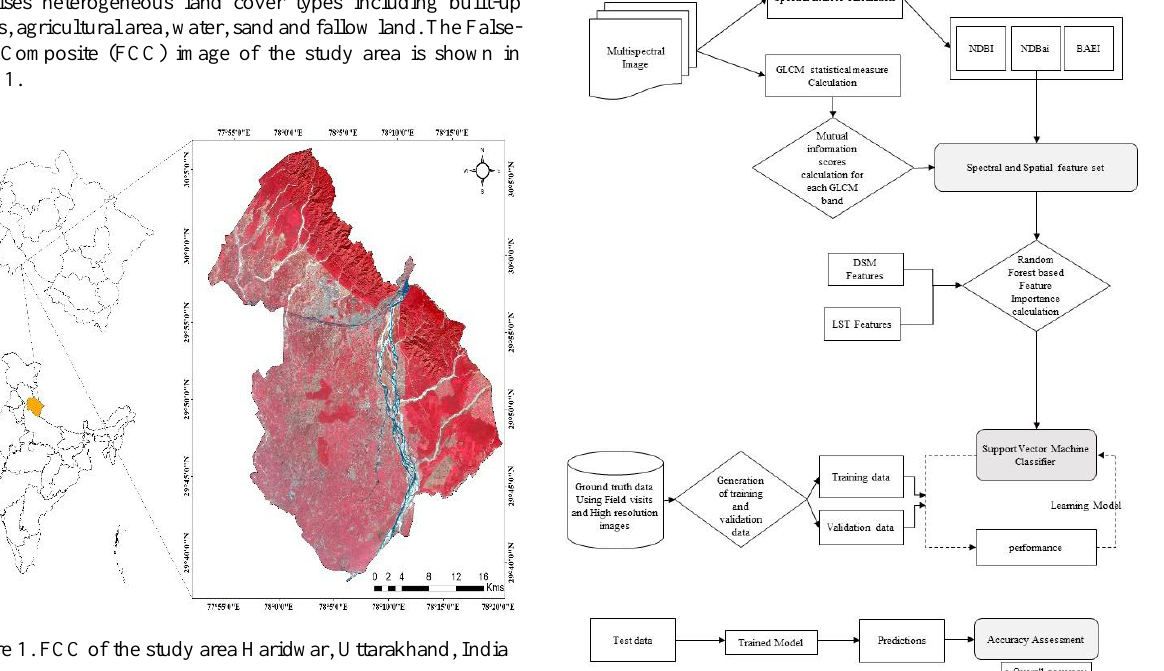
aspect of the study area.